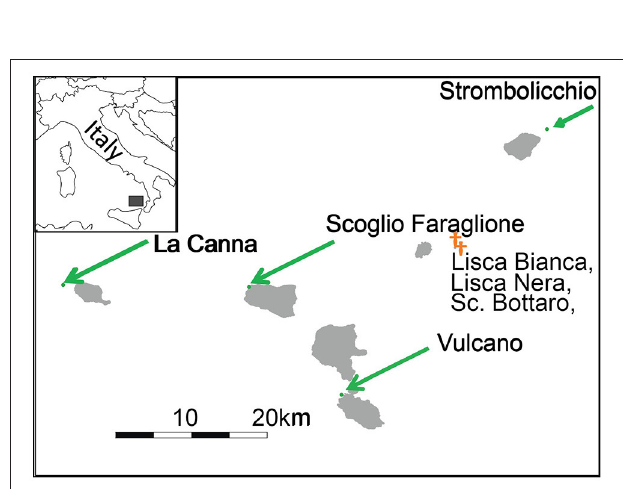
FIGURE 2 | Distribution of extant populations of Podarcis raffonei in the Aeolian Archipelago (green) and of extinct populations with uncertain taxonomic status